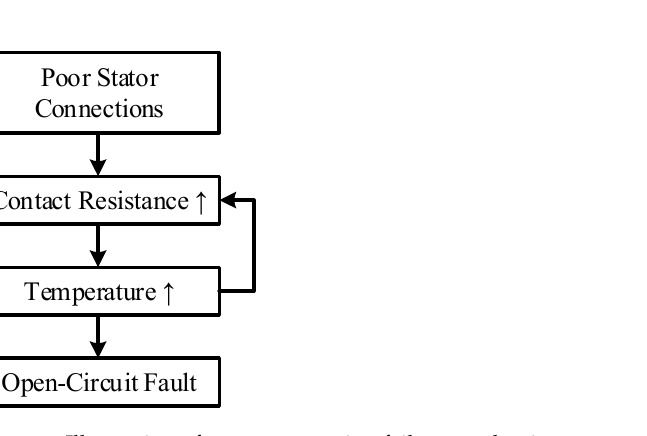
11 of 26 geometry: winding function theory [51]), magnetic equivalent circuit based methods (con- sider geometry, magnetic materials, and winding distribution), and numerical methods (solve Maxwell’s equations: FEM [52,53]). FEM are the most accurate and computational demanding. Concerning fault-tolerant PMSMs, analytical models for prediction of induct- ances and short-circuit current are presented in [54,55]. Modeling of surface mounted PMSMs with stator interturn faults is addressed analytically in [56,57] in abc and dq0 frame. A magnetic equivalent model is proposed in [58] for high accuracy and real time simulations. An equivalent circuit model in [59] employs inductance matrices from FE simulations to conclude that interturn fault severity must consider both number of shorted turns and fault resistance. Connection faults also called high resistance or loose connections are found at termi- nal connections as well as internal generator connections (e.g., parallel branches and/or segments). The connection failure mechanism is illustrated in Figure 3, often initiated with production errors (e.g., a poorly torqued bolted connection). At the nacelle of a wind tur- bine, environmental and operating conditions accelerate fault development. In other words, vibration and heat facilitate the increase of contact resistance and connection tem- perature. Failure causes an open-circuit fault and electrical asymmetry. The debris from burnt insulation and metal may create a conducting path between phases or between phase and ground, thus a short-circuit fault may be detected too. Early detection of con- nection faults is attempted with visual and physical inspection, PD measurements and thermography. Fault signatures are to some extent the same as for insulation faults, thus similarly challenging to detect at an early stage of fault development. However, fault de- tection is perhaps good enough in this scenario (e.g., based on electrical asymmetry), pro- vided that a minor connection repair can be carried out on site as opposed to a major repair following insulation failure. Demagnetization is another important type of faults for PMGs, which failure mech-